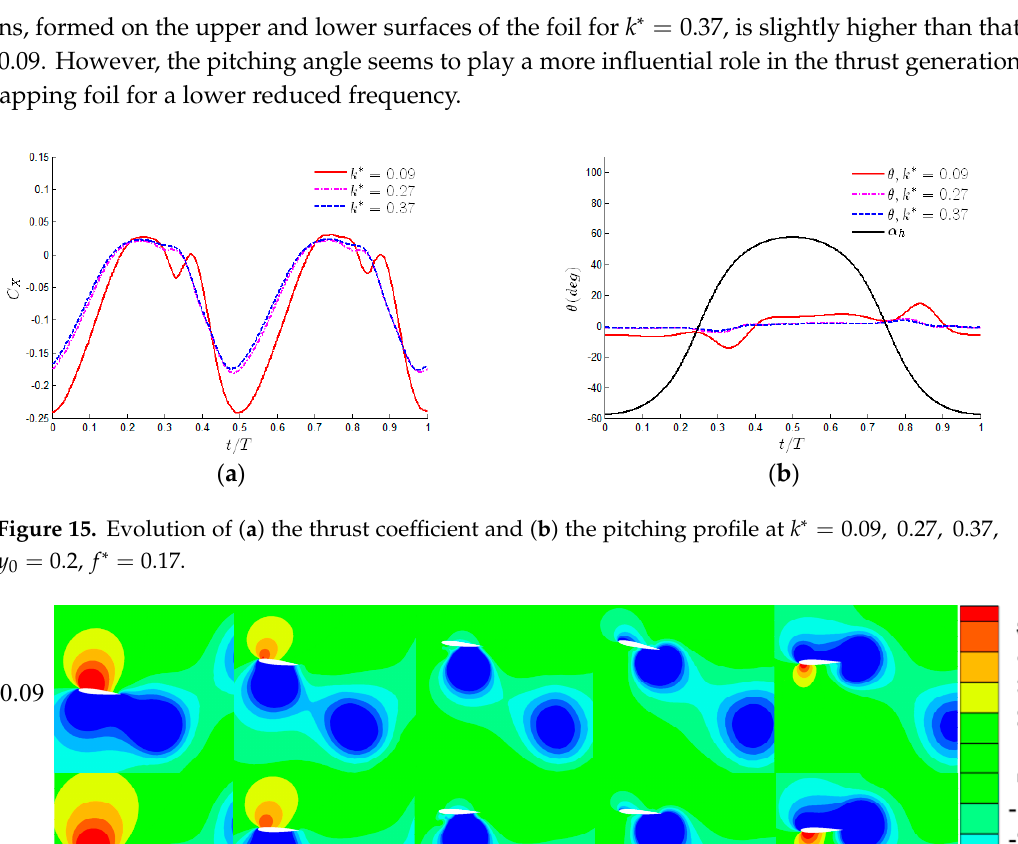
( e ) t/T = 0.35 Figure 14. Instantaneous pressure contours at t/T = 0 − 0.35 for different spring stiffnesses ( 𝑘 ∗ = 0.09, 𝑘 ∗ = 0.27 , ( a ) t/T = 0, ( b ) t/T = 0.1, ( c ) t/T = 0.2, ( d ) t/T = 0.3, ( e ) t/T = 0.35). Figure 11a also illustrates that for a lower reduced frequency ( 𝑦 (cid:2868) = 0.2, 𝑓 ∗ < 0.68 and 𝑦 (cid:2868) = 0.4, 𝑓 ∗ < 0.34 ), the propulsive performance of the flapping foil decreases as the spring stiffness increases, and both the mean values of the output power coefficient and the propulsive efficiency decrease. The time history of the thrust coefficient and pitching profile, during one period, is illustrated in Figure 15. It is pointed out that the maximum thrust coefficient of 𝑘 ∗ = 0.09 is higher